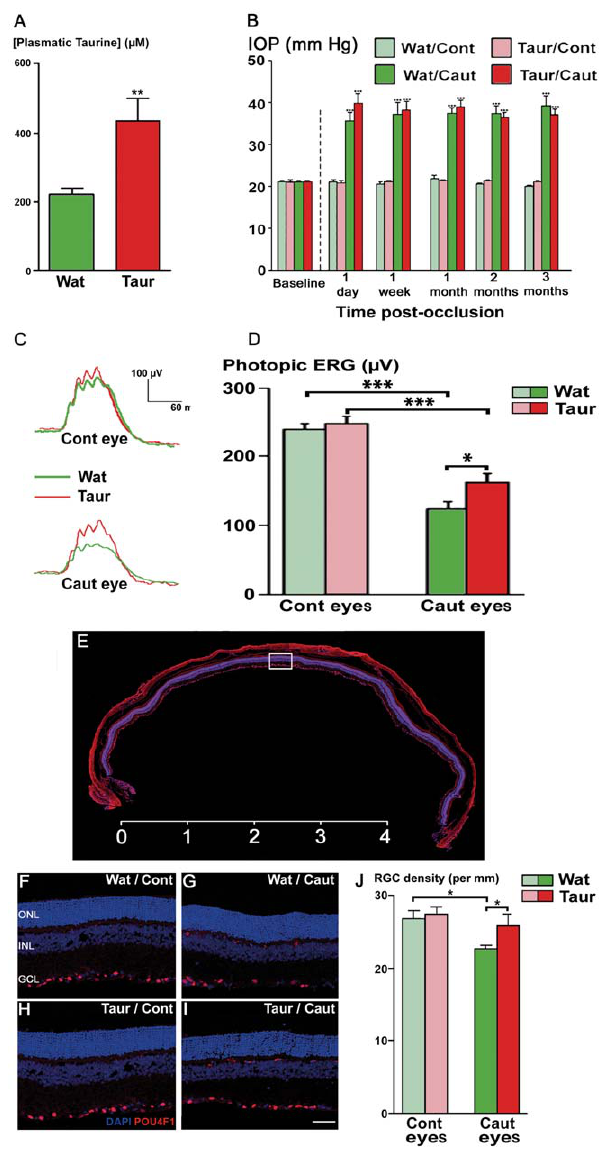
Figure 5. Taurine supplementation prevents RGC degeneration in glaucomatous Long-Evans rats following episcleral vein occlusion. A) Taurine plasmatic levels in Long-Evans rats drinking taurine-free water (Wat; green bar; mean 6 s.e.m., n=21) or taurine- supplemented water for 3 months (Taur; red bar; mean 6 s.e.m., n=24; **p , 0.01, student’s t-test). B) Intraocular pressure (IOP) levels measured at regular time intervals after episcleral vein occlusions by cauterization on the operated right eyes (Caut) and unoperated left eyes (Cont) in rats drinking taurine-free water (Wat, green bars) or in taurine-treated rats (Taur; red bars). The difference between the IOP remained statically significant between the operated and unoperated eyes in both animal groups throughout the study (mean 6 s.e.m., n . 14 for all groups; ***p , 0.001 as compared to water/control eyes, one-way ANOVA followed by a Bonferroni post-hoc test). C) Representative photopic electroretinograms (ERG) recorded from an operated right eye (Caut eye) and an unoperated left control eye (Cont eye) after 3 months of episcleral vein occlusion in taurine-treated rats (Taur, red traces) and in control rats drinking taurine-free water (Wat; green traces). D) Quantification of photopic ERG amplitudes measured from the left unoperated eyes (Cont eyes) and right operated eyes (Caut eyes) in taurine-supplemented rats (Taur; red bars; mean 6 s.e.m., n=24) or control rats drinking taurine-free water (Wat; green bars; mean 6